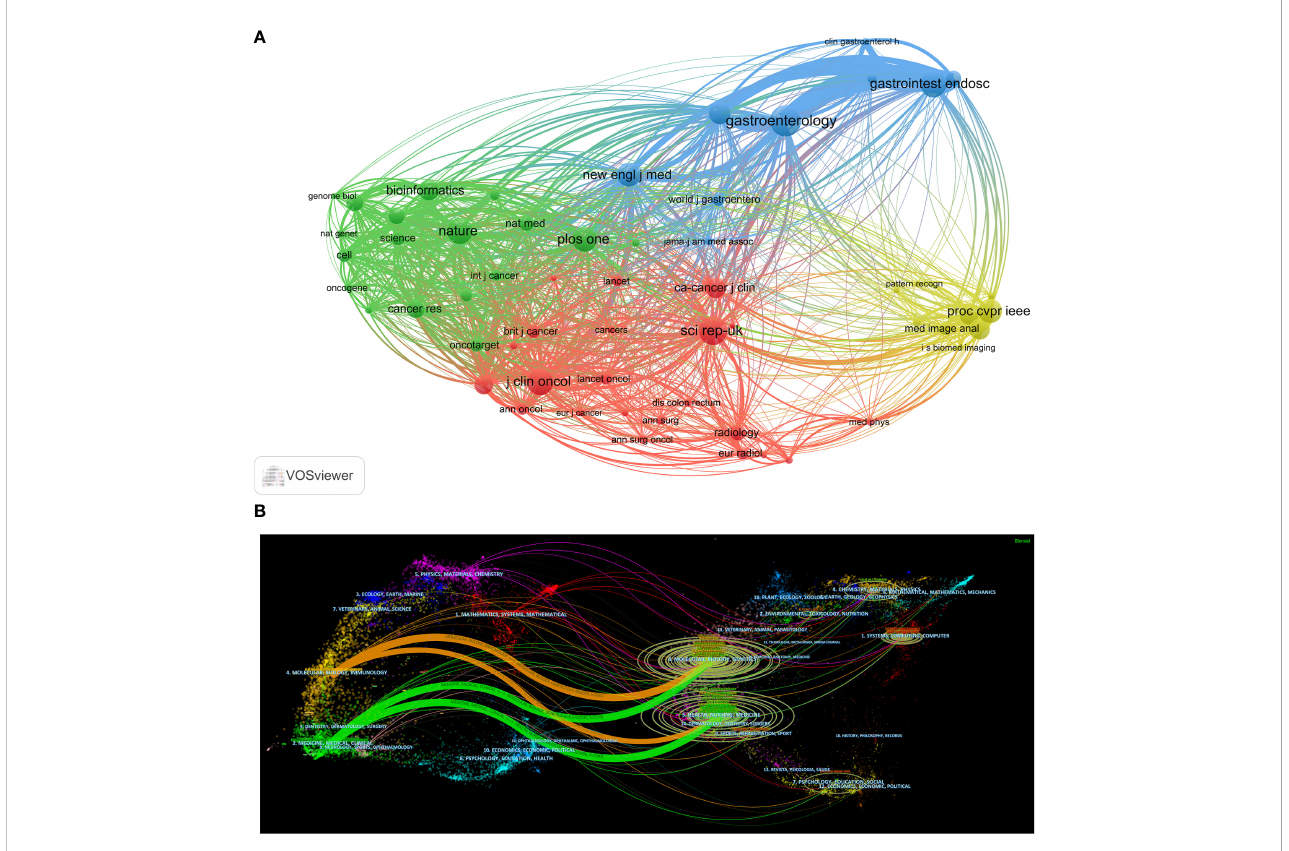
FIGURE 4 Citation relationship between journals. (A) Co-citation relationships between journals (The circles represent the number of articles cited by CRC in a journal, and the connecting lines represent a paper citing two different journals separately). (B) A dual-map overlap of journals on AI in CRC (On the left side are the citing journals. On the right side are the cited journals. The color represents the classi fi cation of journals. The curve is the citation line. The ellipse ’ s long axis represents the number of papers cited in the same subject journal. The short axis of the ellipse represents the number of authors of papers in journals on the same